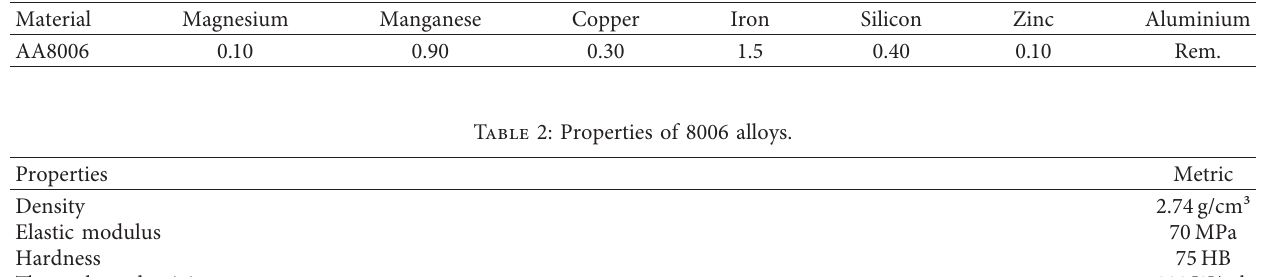
Table 1: Chemical elements of AA8006 (wt.%).